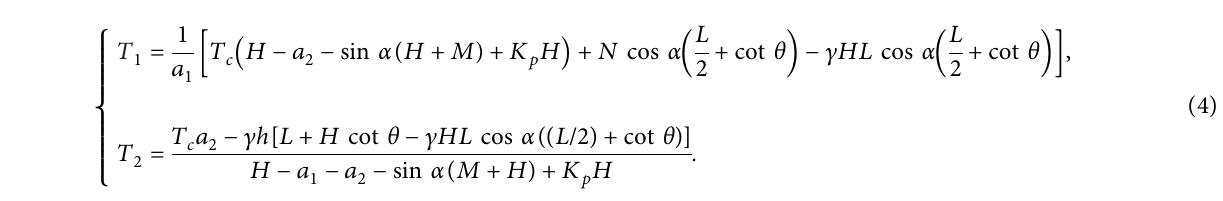
Figure 3: The distribution law of abutment pressure in the inclined direction of the working face under the condition of large inclination angle. (a) Support pressure distribution of working face under anti-inclined accumulation structure. (b) Support pressure distribution of working face under inclined accumulation